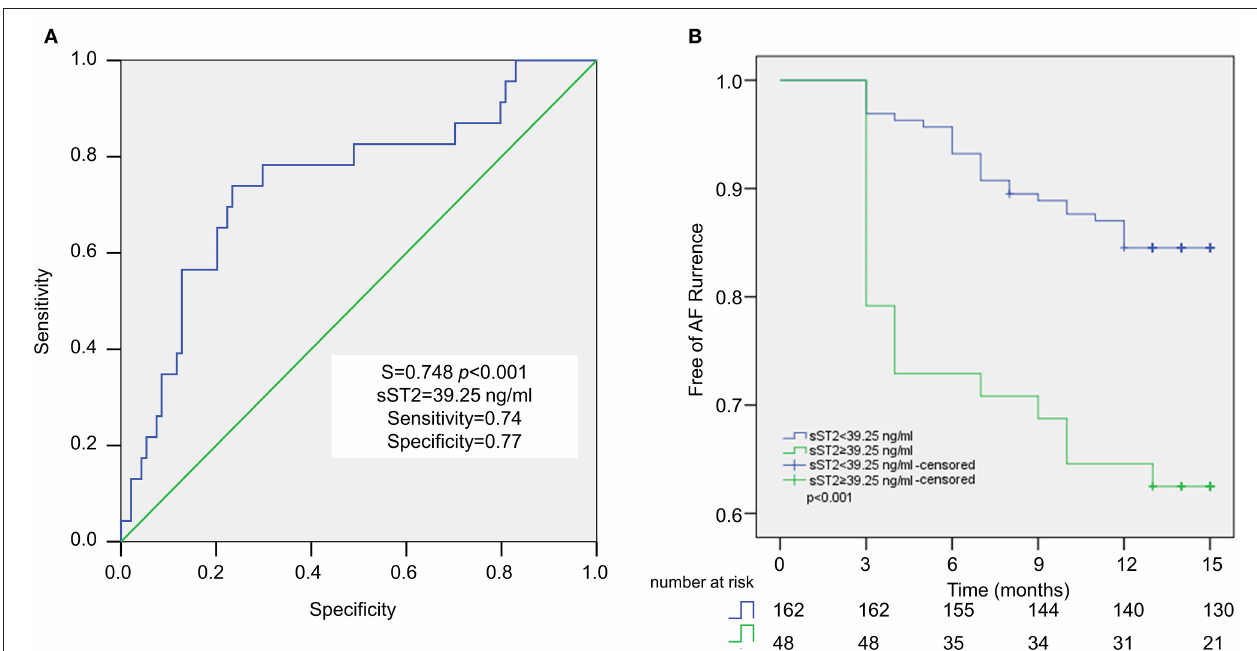
FIGURE 3 | Baseline sST2 for the prediction of AF recurrence after ablation in persistent AF patients. Receiver operating characteristic (ROC) curve analysis revealed the cutoff value for sST2 is 39.25ng/ml, with sensitivity at 74%, and specificity at 77% (A) . Recurrence rate after ablation is examined by Kaplan–Meier analysis (B) .